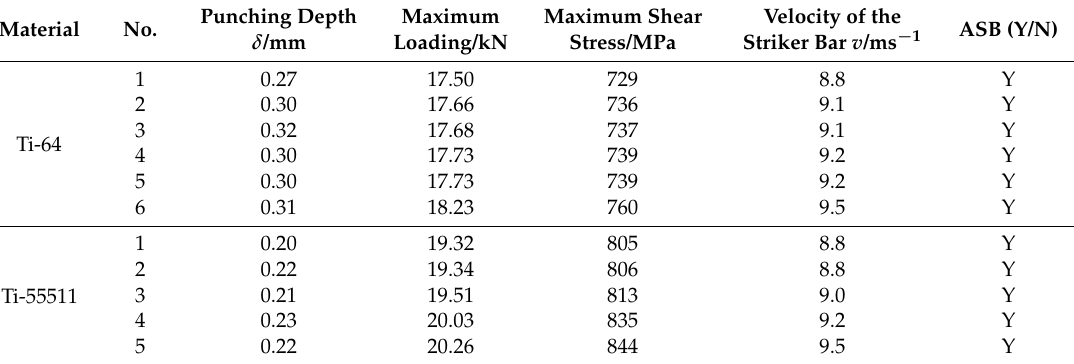
Figure 3. ( a ) Typical strain gage signals recorded in SHPB test at room temperature; ( b ) recorded signals after initiation to zero for elastic waves analysis. Table 1. Experimental parameters.